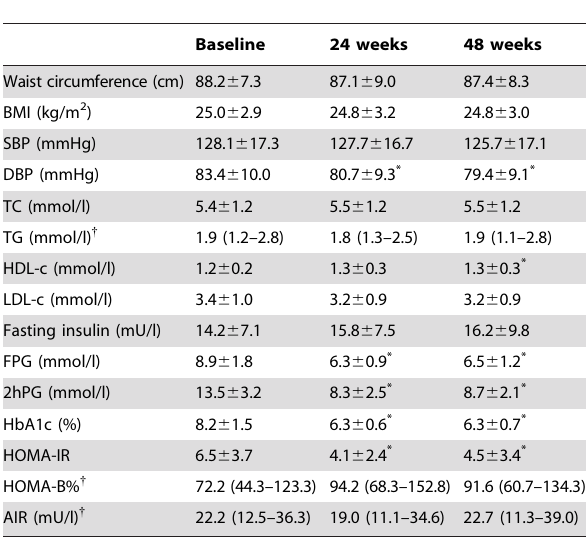
Table 1. Clinical characteristics of study subjects.